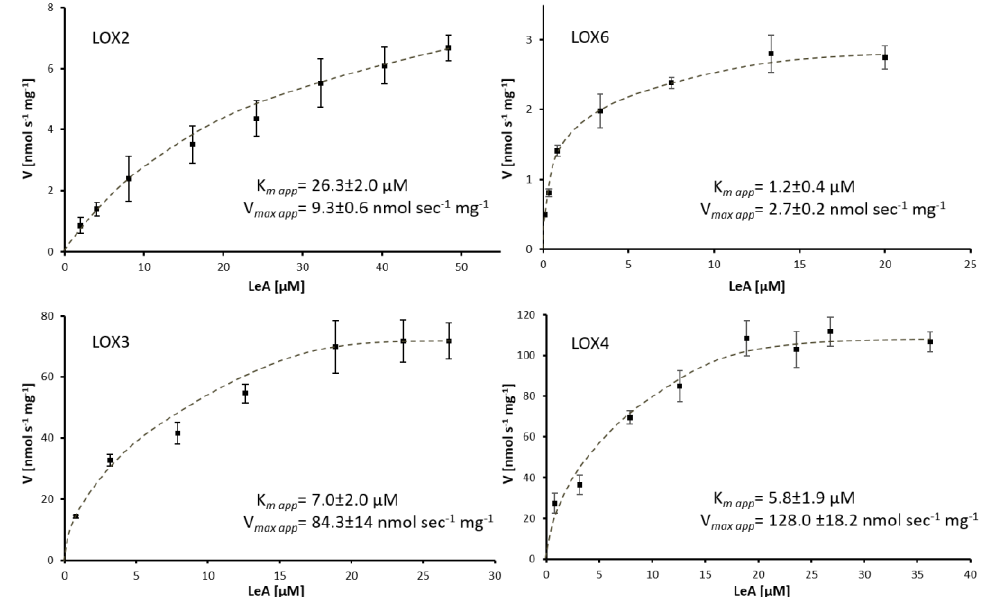
Figure 3. Activity of 13-LOX with their favored substrate, LeA. Graphs are means ± SD of n ≥ 3, derived from a nonlinear regression fit using the Michaelis Menten equation. The apparent (app) value is added to the parameters in order to indicate that 13-LOX enzymes differed in purity and iron load. For more details, see text and Section 4. Table 1. Substrate specificities of LOX2, LOX3, LOX4 and LOX6.